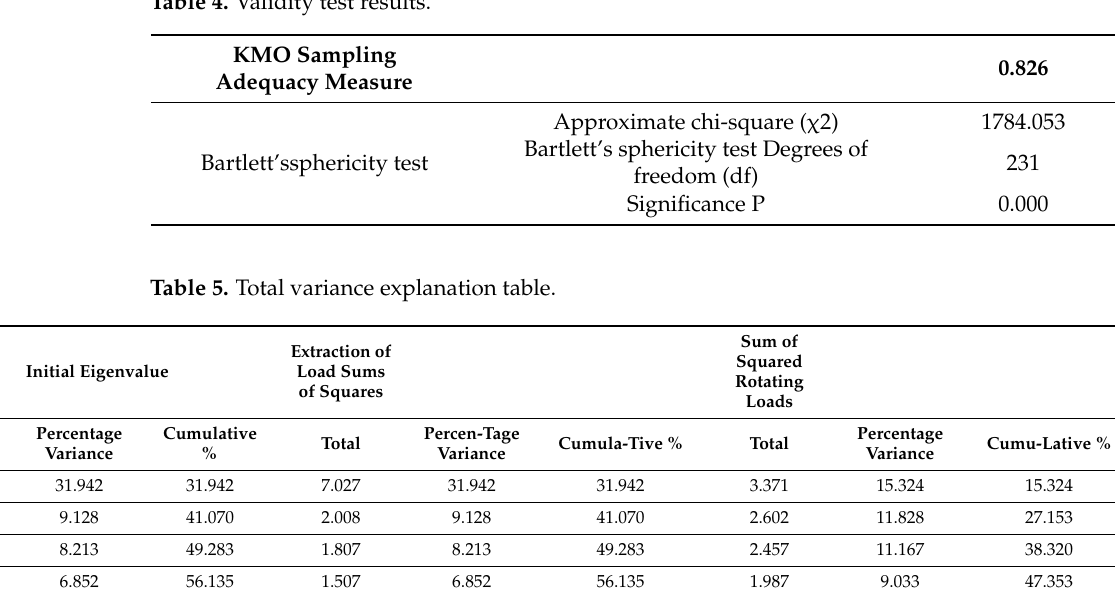
Table 4. Validity test results.